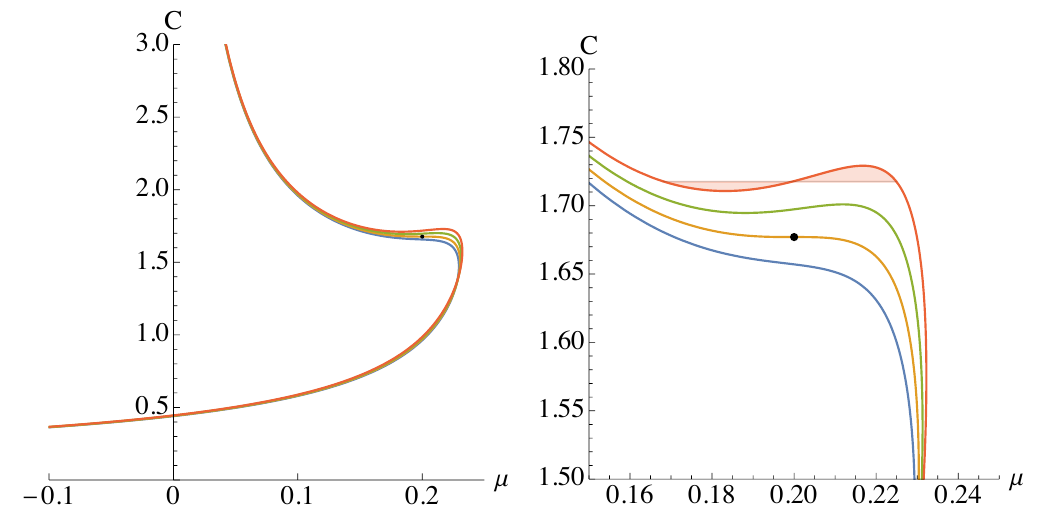
˜ Figure 7 . Isotherms in the C − µ plane for d = 4 . The parameters used here are Q = 1 , R = 1 √ and T = T = 4 (orange), T = 0 . 999 T (blue), T = 1 . 001 T (green) and T = 1 . 002 T 3 crit crit crit crit 5 π (red). The right plot shows a zoomed-in version of the left plot around the critical point (black dot). For T > T (e.g. red curve), the curve displays a “wriggle” similar to the familiar P − V crit phase diagram in the Van der Waals liquid-gas phase transition. The phase transition takes place in accordance with Maxwell’s equal area